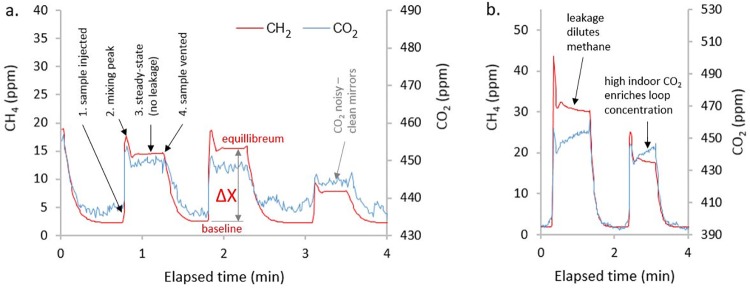
Data excerpts showing a. stages of a closed-loop measurement (without leakage, but noisy CO2 response suggesting mirror cleaning needed), and b. a leaking system; the pump draws ambient laboratory air into the partially evacuated circuit diluting methane (red), and increasing CO2 (blue) due to indoor air with elevated CO2.